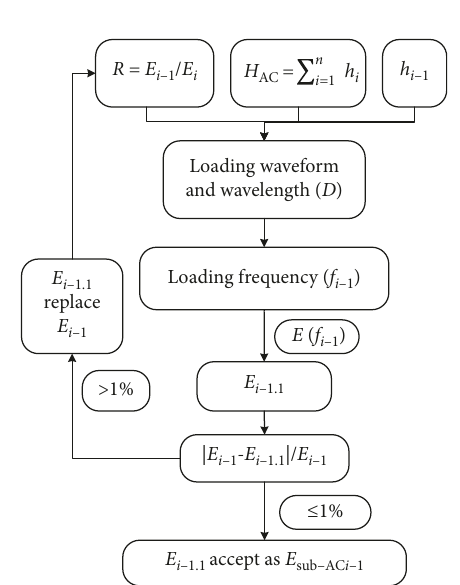
Figure 7: Dynamic modulus obtaining methodology flow